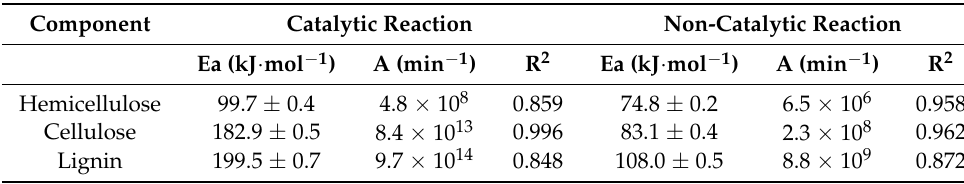
Table 4. Kinetic parameters calculated by applying the Kissinger method.